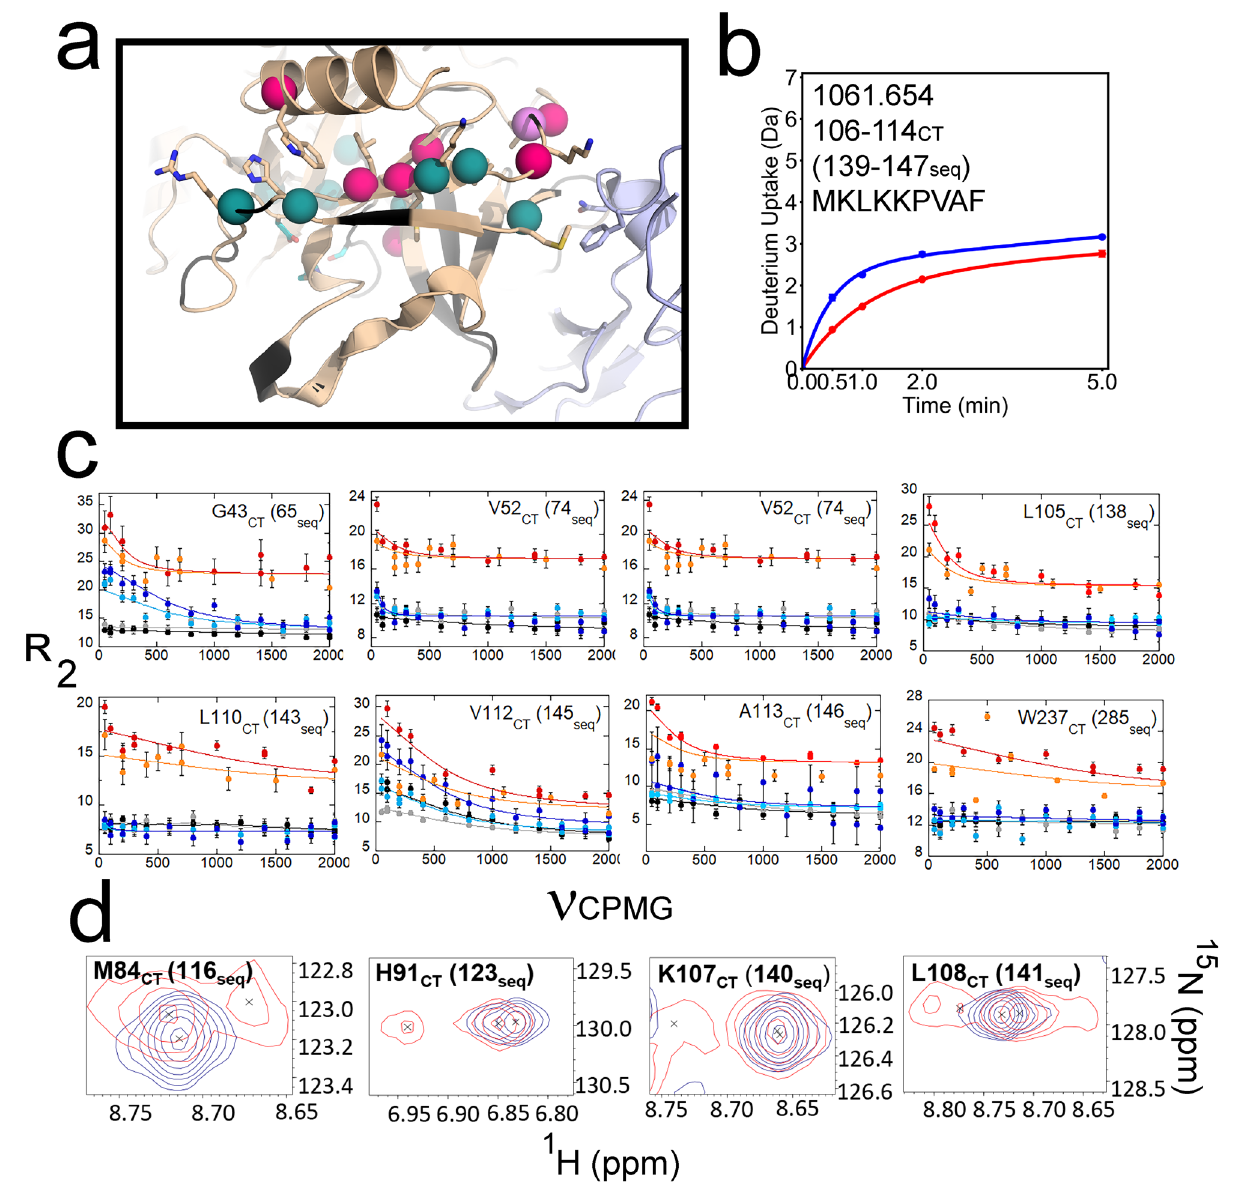
Figure 2. ( a ) Structure of thrombin (wheat) bound to TM456 (light blue) [PDB ID: 1DX5]. The residues corresponding to resonances missing from the thrombin-TM456 HSQC are colored black. The residues corresponding to multiplet resonances (teal spheres), resonances experiencing increased μs-ms dynamics in thrombin-TM456 compared to apo-thrombin (pink spheres), and resonances experiencing similar μs-ms dynamics in thrombin-TM456 and apo-thrombin (violet spheres) and the catalytic triad (cyan sticks) are shown. ( b ) Deuterium uptake plot for the peptide spanning residues 106-114 CT (139-147seq; MH + 1061.654). ( c ) CPMG plots for resonances in the thrombin N-terminal β-barrel (symbols as in Fig. 1). ( d ) Examples of thrombin-TM456 HSQC (red) doublet resonances compared to apo-thrombin (blue) resonances for residues in the N-terminal